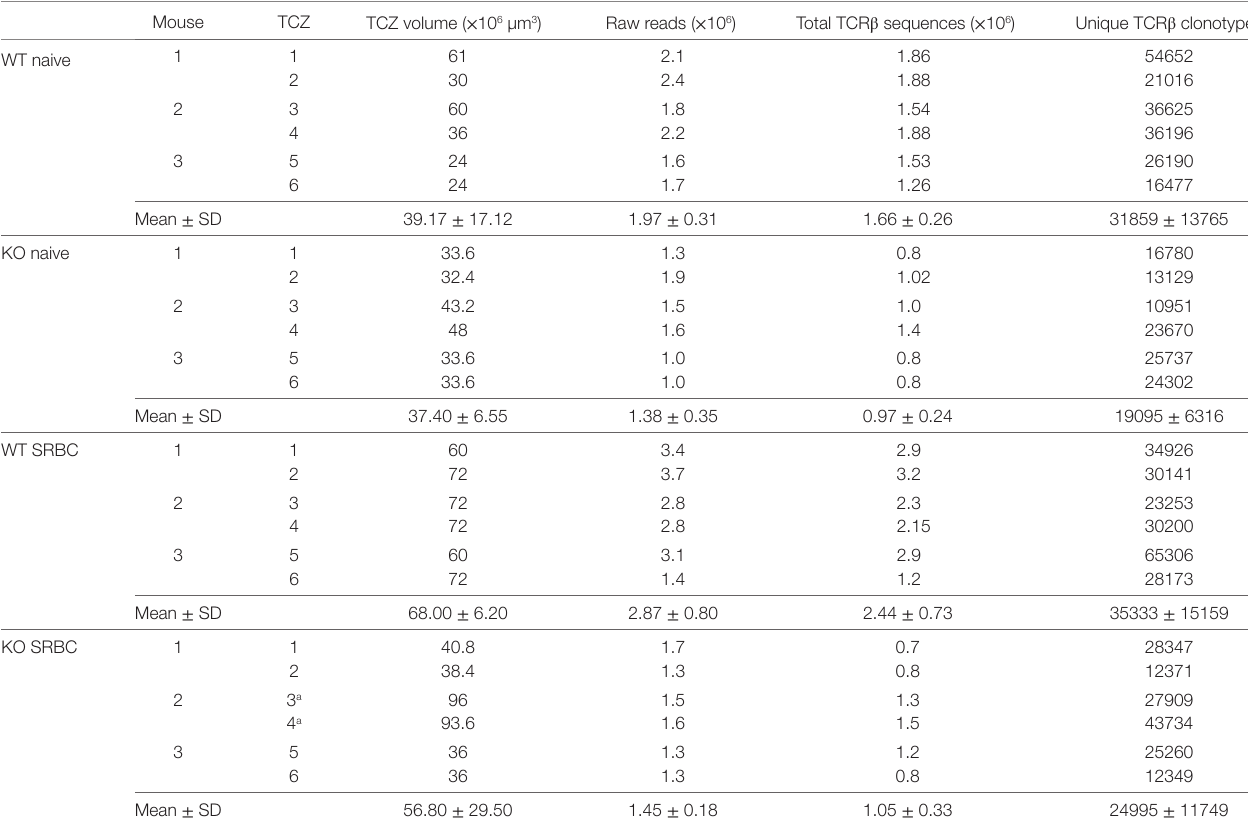
TaBle 1 | TCZ volumes, raw reads, total, and unique TCR β sequences obtained from laser-captured splenic TCZ in wild-type (WT) and CD154-deficient (KO)